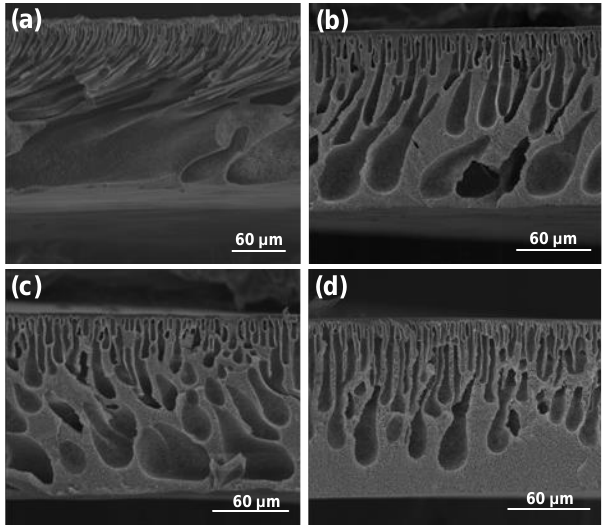
Figure 3. Membrane prepared with NMP as the solvent by coagulation into mixtures of water and isopropanol (concentration of isopropanol indicated): ( a ) 0% Iso, ( b ) 50% Iso, ( c ) 70% Iso, and ( d ) 100% Iso.